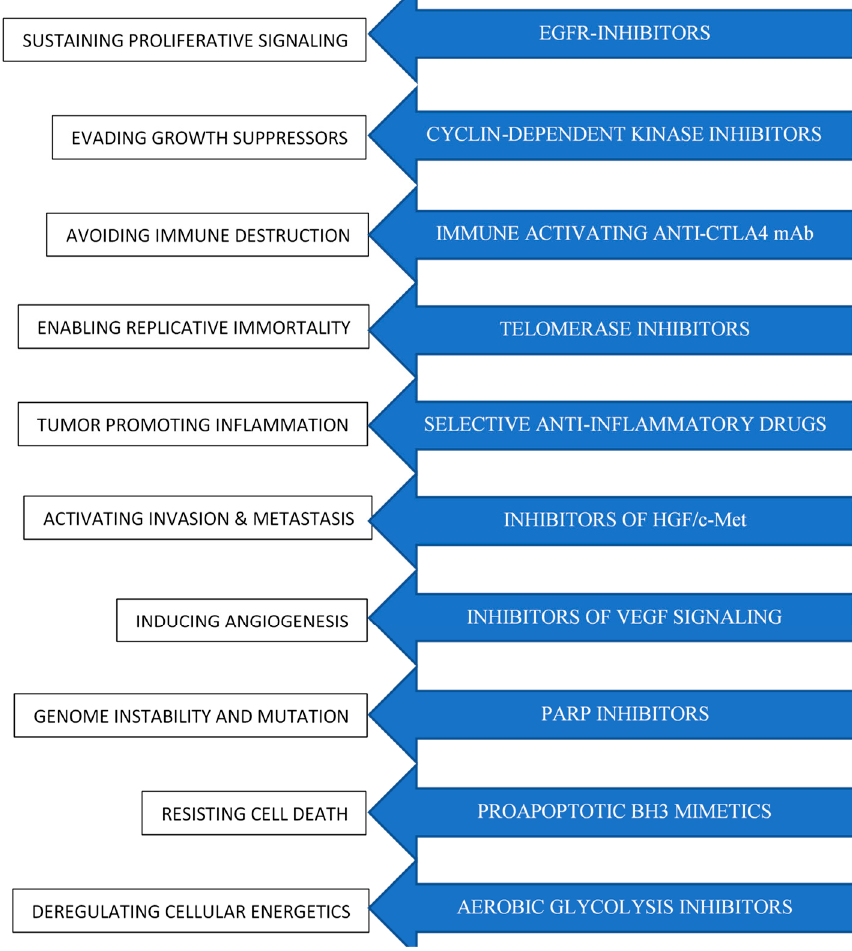
Figure 1. Chemotherapeutic agents designed to target different hallmarks of cancer [2]. Both cytotoxic and cytostatic agents are able to induce cell death by damaging cells at different levels.